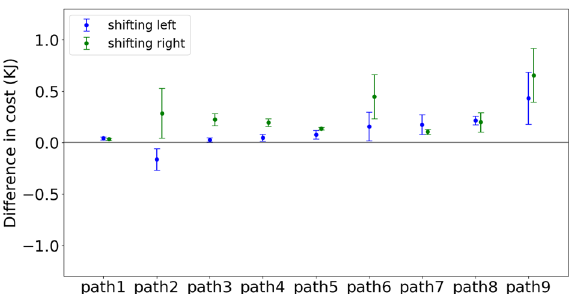
Figure 6. The difference in the energetic cost for the path perturbation. Each of the nine paths has two perturbations of 5 cm: left in blue, right in green. This main result shows that the original path is always the least expensive for both averages across subject traces. The difference in the energetic cost for the path perturbation is not very clear but still reliable, with a p-value less than 0.01.